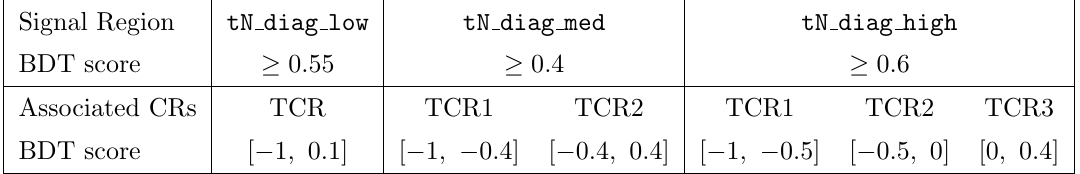
Table 16 . Overview of signal region and control region de(cid:12)nitions for the BDT analyses targeting the compressed bino LSP scenarios. The selections described in table 7 are applied, except for the BDT score. Square brackets denote